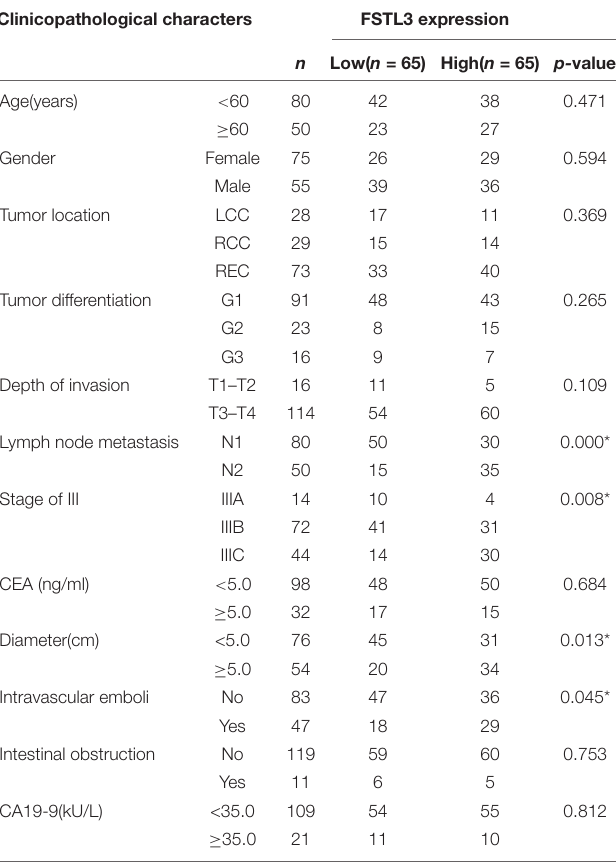
inhibit YAP1 activity by treating FSTL3-overexpressing DLD- 1 and DLD-1-vector control cells with 0.5 µ M